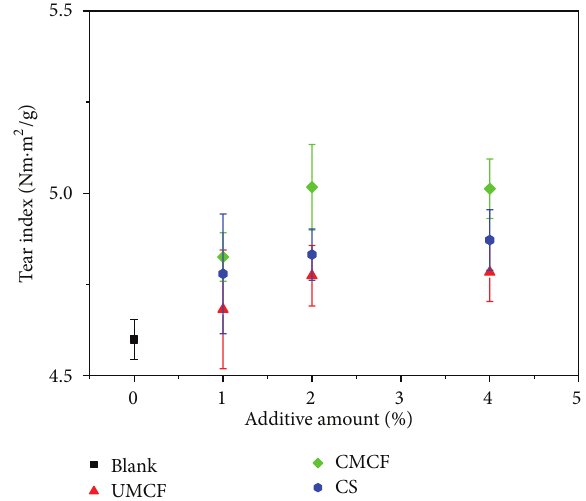
Figure 8: Tear index of paper sheets with various additive amounts of three additives (UMCF, CMCF, and